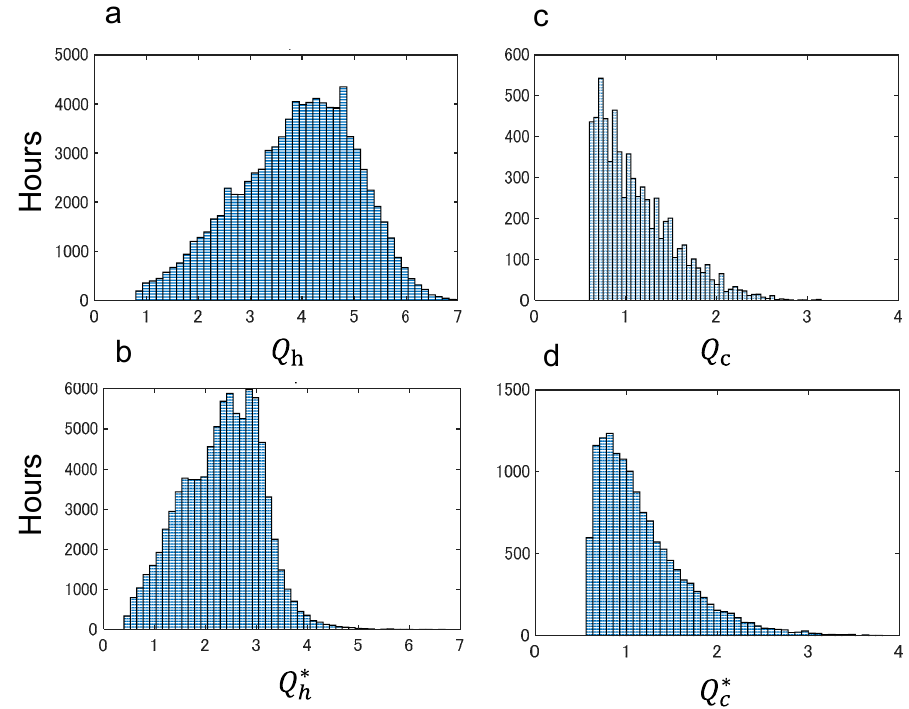
Figure 4. Histograms of hourly thermal pulses for heating ( left ) and cooling ( right ) in ( a ) the present (2001–2020) and ( b ) the future (2076–2096) in Sapporo, and in ( c ) the present and ( d ) the future in Tokyo.